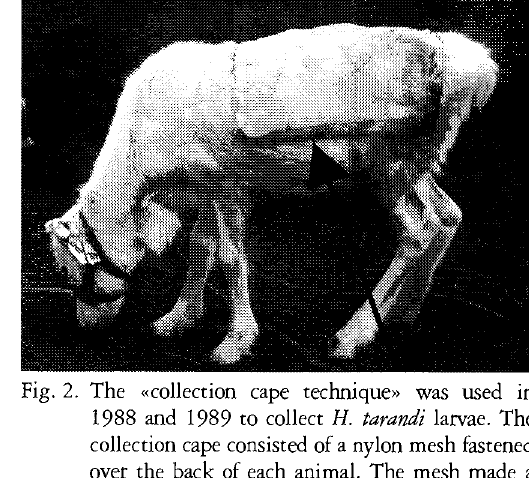
Fig. 2. The «collection cape technique* was used in 1988 and 1989 to collect H. tarandi larvae. The collection cape consisted of a nylon mesh fastened over the back of each animal. The mesh made a transparent bag into which the larvae collected when they emerged. The arrow points at one dropped larva.